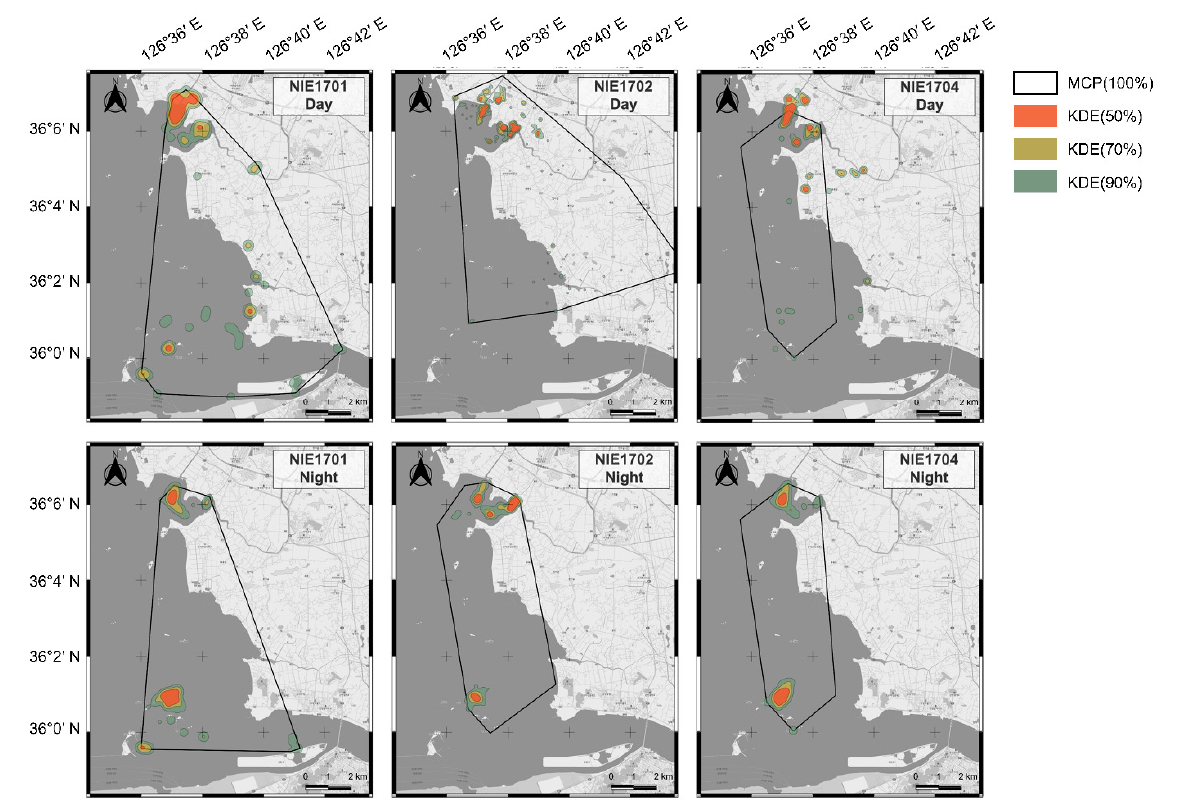
Figure 2. Home range estimation for Swan Geese using a minimum convex polygon (MCP) and kernel density estimation (KDE 50%, 70%, 90%) between day (08:00–18:00) and night (20:00–06:00). Table 2. Home range estimations for each Swan Goose individual. Tracking ID